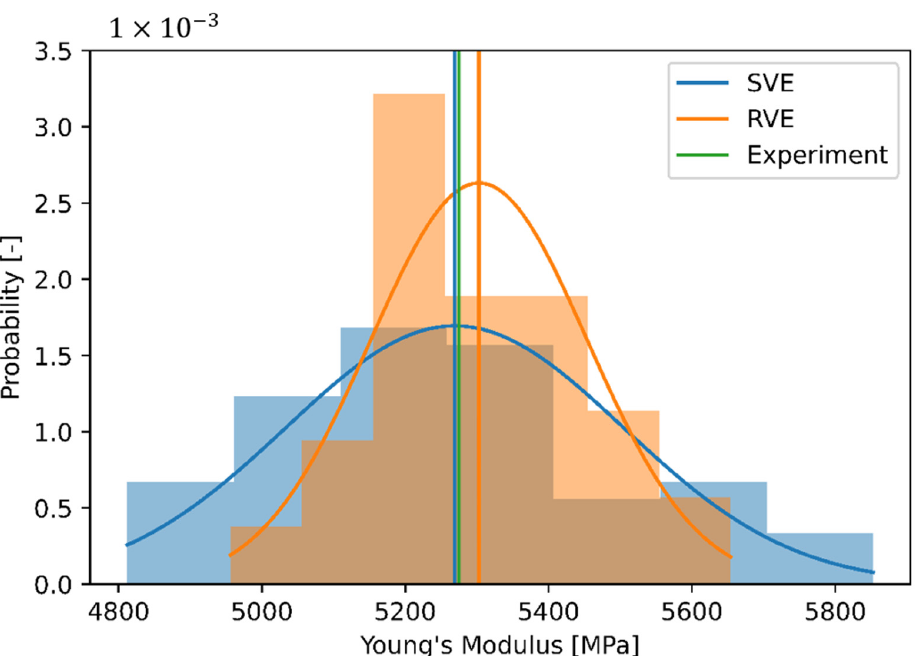
Figure 8. Histograms, normal distributions and mean values of the effective stiffnesses, calculated with the RVE and SVE approach as well as mean value of experimentally measured stiffness. We used 100 fibers in 60 different fiber ensembles for both approaches.